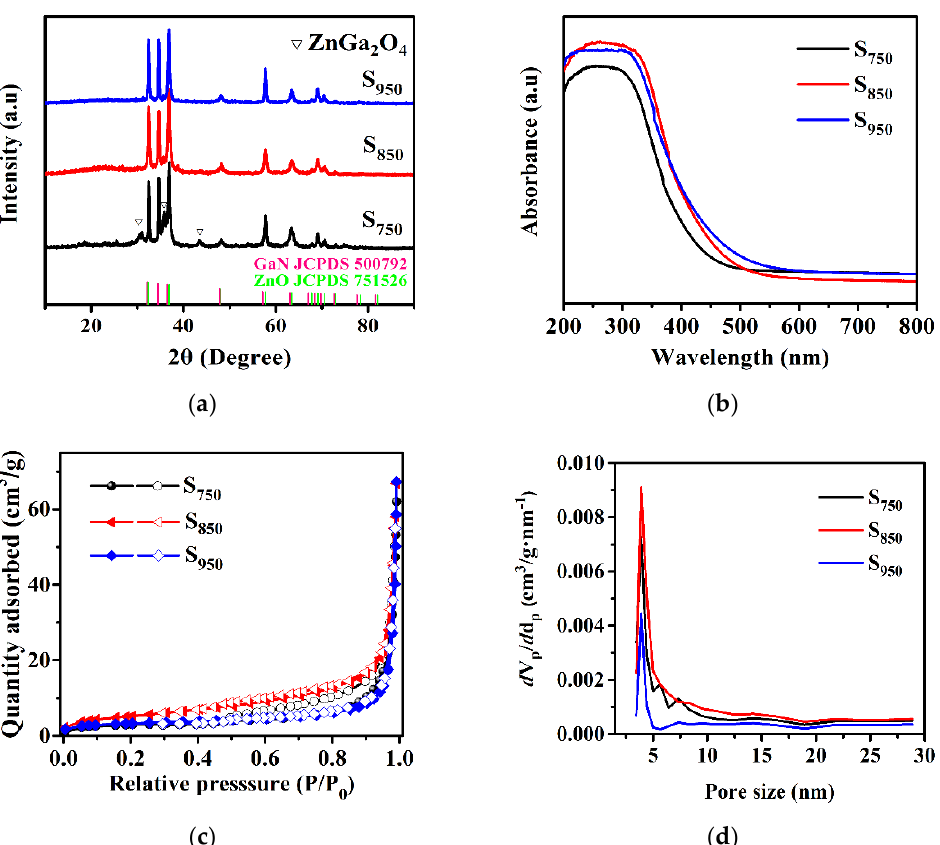
Figure 1. ( a ) XRD patterns; ( b ) UV-visible absorption spectra of the S 750 , S 850 , and S 950 samples; ( c ) adsorption-desorption isotherms; and ( d ) pore size distribution of GaN:ZnO solid solution.